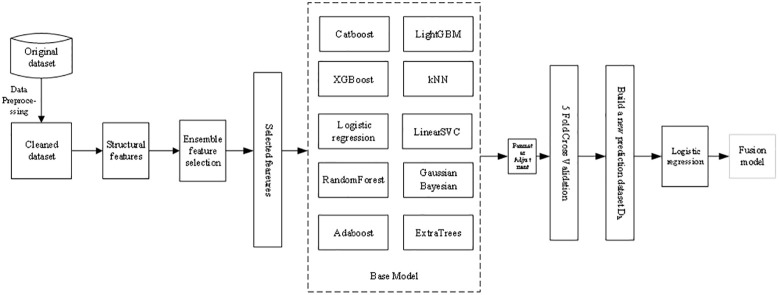
Overall framework.